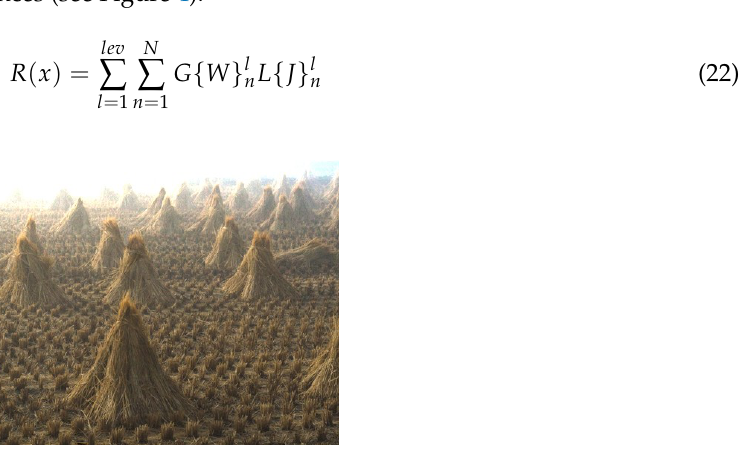
Figure 4. The R ( x ) image obtained with a fusion of 255 images and W = [ 1 ] n unit